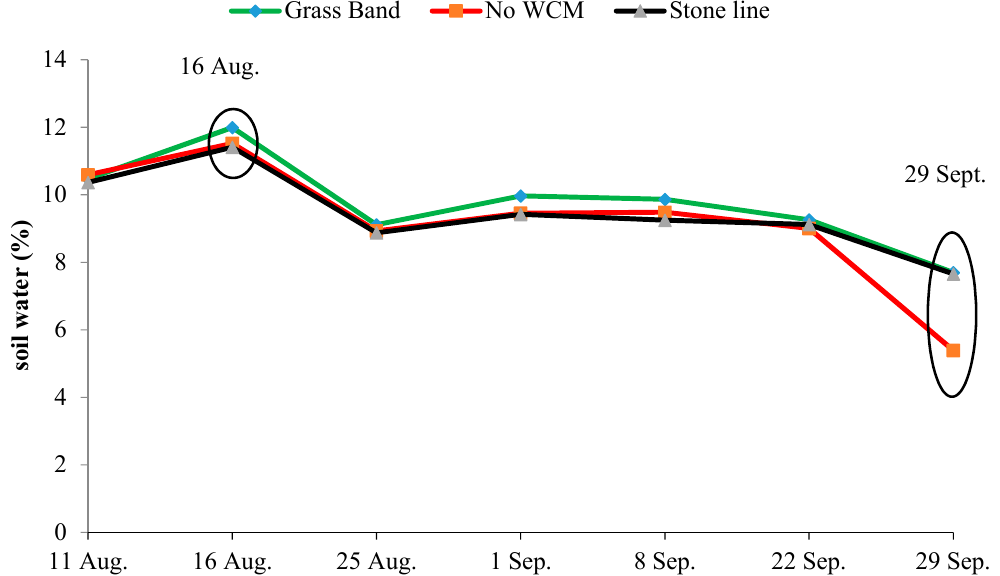
Figure 4. Soil water variation during the 2010 cropping season at Saria Research Station, Burkina Faso.